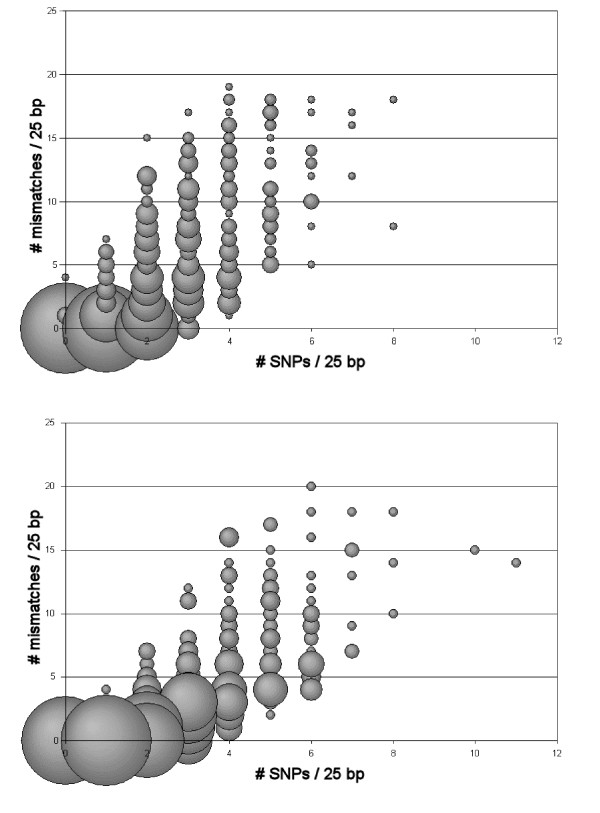
SNP density versus mismatch density per 25 bps in chimpanzee and gorilla mtDNA genomes. Bubbles are proportional to the number of events at each point.